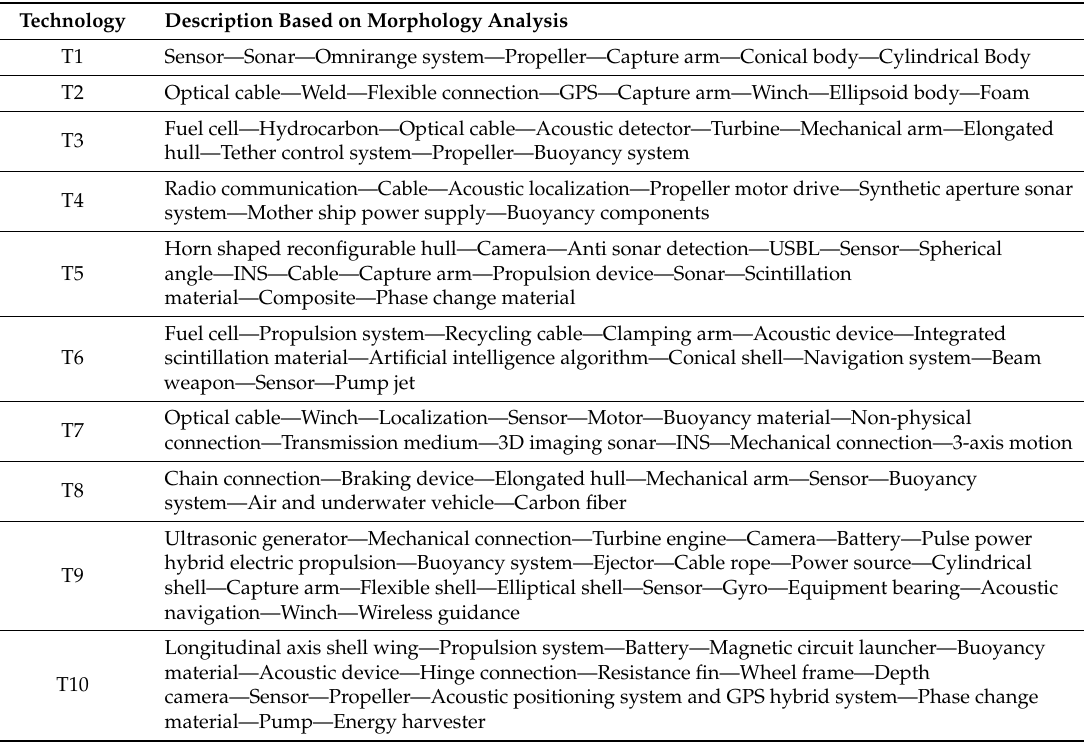
Table 5. Technology description based on morphological analysis